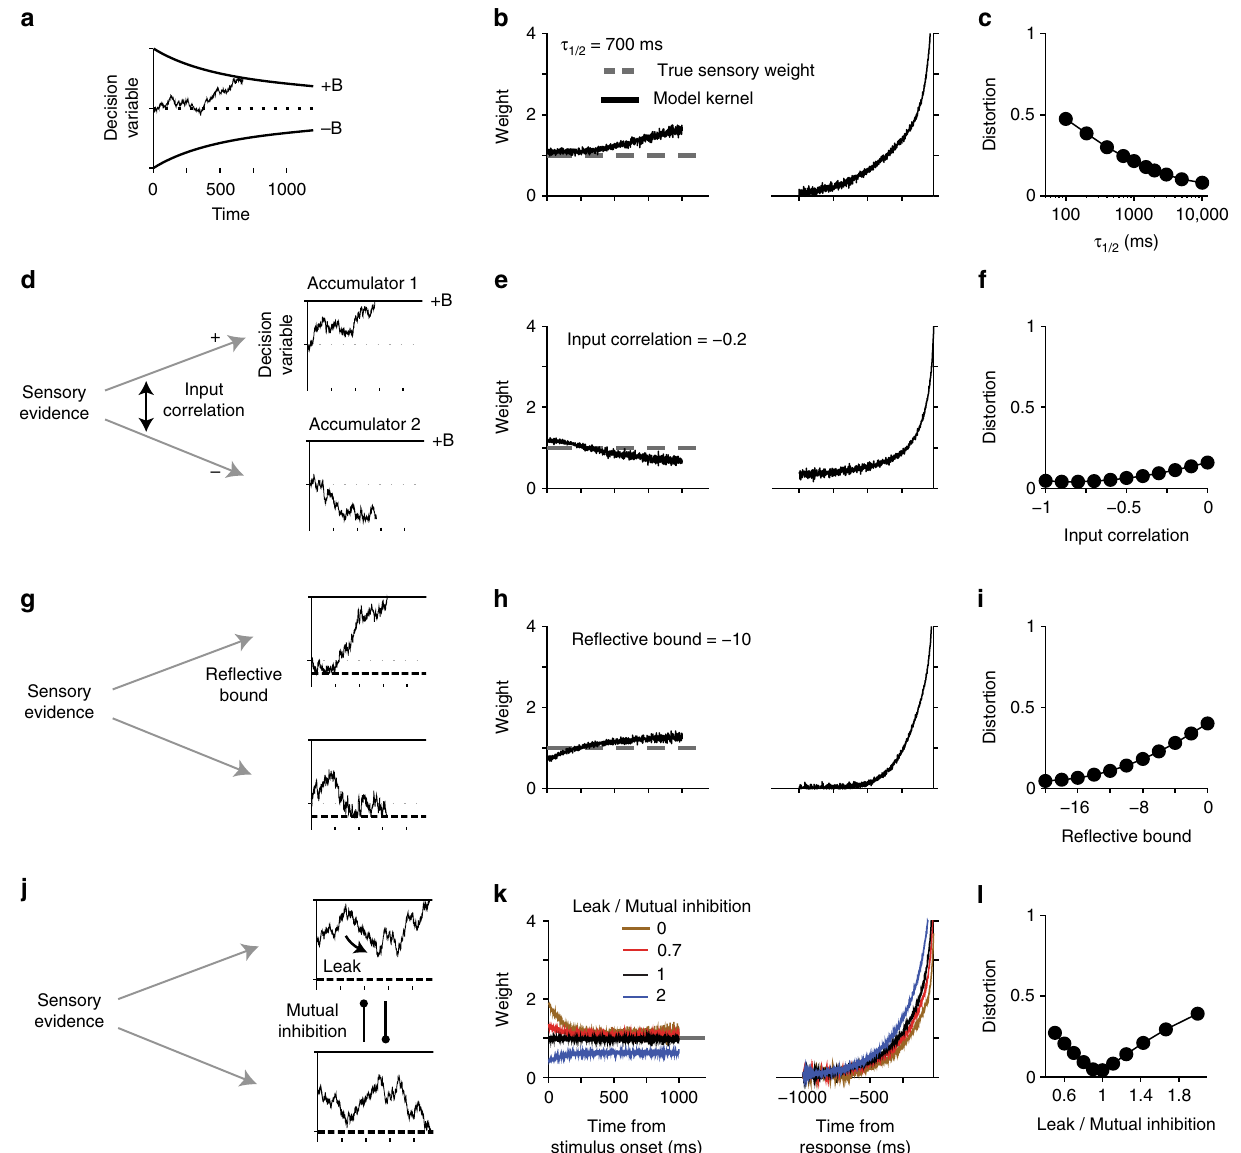
Fig. 6 Psychophysical kernels are susceptible to changes of decision bound, input correlation, mutual inhibition, integration time constant, and limited dynamic range. The fi gure shows extensions of DDM and systematic deviations that additional realism to the model can cause in psychophysical kernels. Conventions are similar to Fig. 3, except that we focus only on RT tasks. Also, to isolate the effects of different model parameters from the effect of non- decision time, we use zero non-decision time in these simulations. a – c Collapsing decision bound (urgency signal) in fl ates the psychophysical kernel over time. The rate of bound collapse is de fi ned by τ 1/2 — the time it takes to have a 50% drop in bound height. d – f Extending DDM to a competition between two bounded accumulators reveals that input correlation of the accumulators has only modest effects on psychophysical kernels, causing an initial overshoot followed by an undershoot compared to true sensory weights. g – i The presence of a lower re fl ective bound in the accumulators causes an opposite distortion: an initial undershoot followed by a later overshoot. j – l Balancing the effect of mutual inhibition by making the integrators leaky causes the model to behave like a DDM, eliminating the effects of both the inhibition and leak on the psychophysical kernels (black curves in m). Any imbalance between leak and inhibition, however, causes systematic deviations in the kernels from the true sensory weights (brown, red, and blue curves in k ). See Supplementary Fig. 8 for more